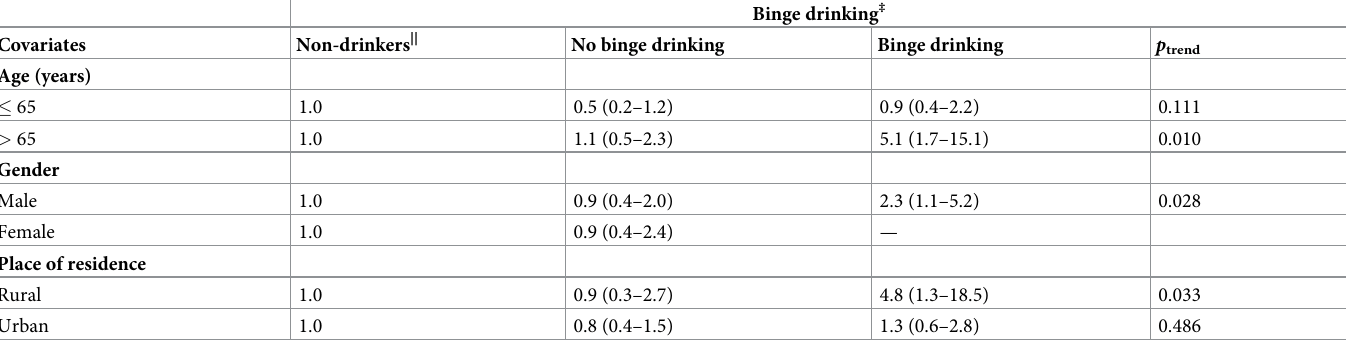
Table 4. Estimated risk (cid:3) † - odds ratio (95% confidence intervals) of acute myocardial infarction in relation to binge drinking in separate strata of selected